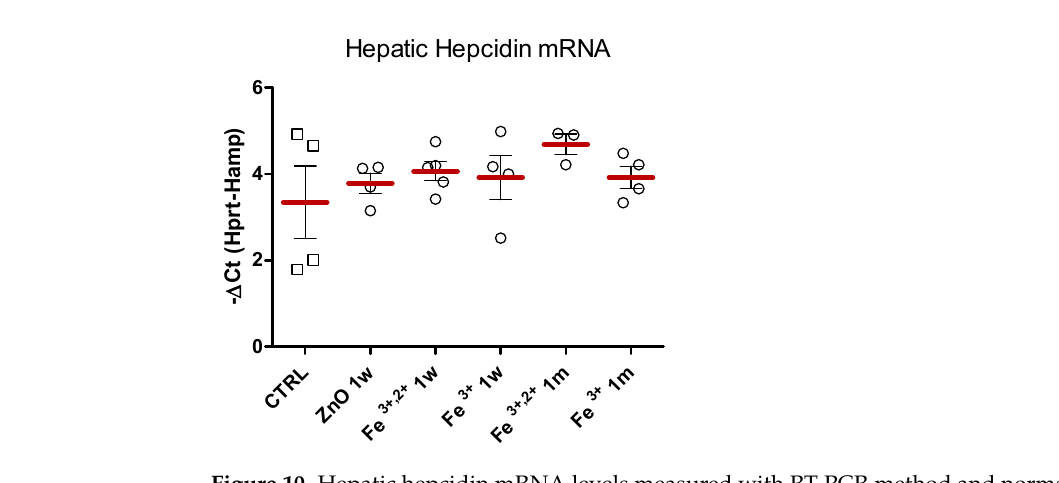
Figure 10. Hepatic hepcidin mRNA levels measured with RT-PCR method and normalized to transcripts encoding hypoxanthine-guanine phosphoribosyltransferase genes (Hprt). Results obtained at different time points (1 w and 1 m) after intra-gastric administration of ZnO, ZnO:Fe 3+,2+ or ZnO:Fe 3+ nanoparticles versus the control group (CTRL). Data presented as mean (±SEM) for control ( n = 4) vs. experimental groups (ZnO 1 w n = 4; Fe 3+,2+ 1 w n = 4; Fe 3+ 1 w n = 4; Fe 3+,2+ 1 m n = 4; Fe 3+ 1 m n = 4). Range presented as squares for CTRL and circles for experimental groups.